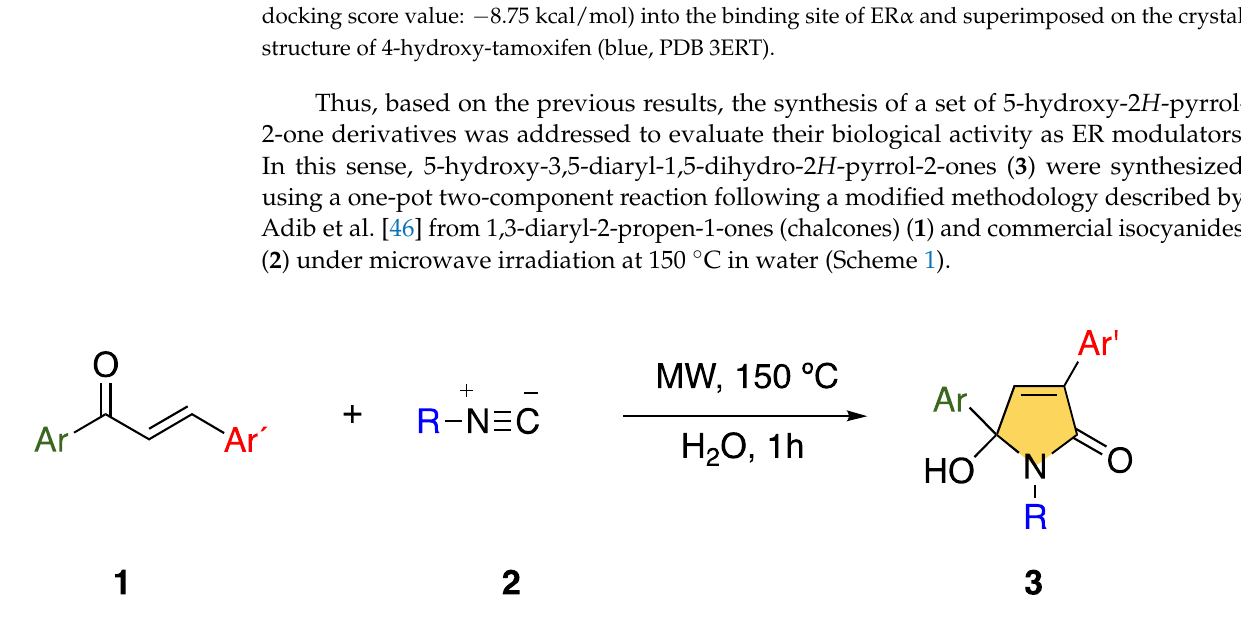
Figure 2. Structures and yields of 5-hydroxy-3,5-diaryl-1,5-dihydro-2 H -pyrrol-2-ones ( 4 – 50